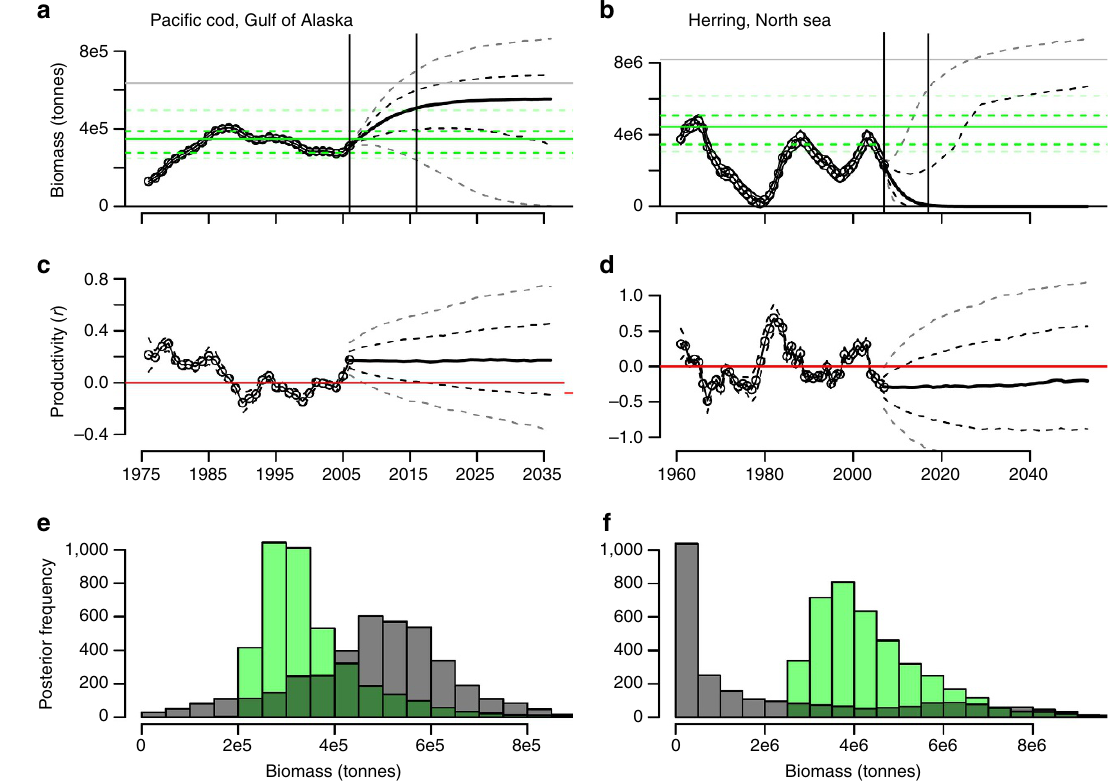
Figure 3 | Examples of recovery timeline forecasting. ( a , b ) Two examples of non-stationary biomass time series to which the non-stationary Graham– Schaefer model was fit. The solid grey lines indicate the mean posterior carrying capacity K ; solid green lines give the mean posterior B MSY (with 50 and 90% intervals as dotted green lines). Vertical black lines differentiate the observed period and 10 years after. The mean biomass trajectories beyond the observed period are given as solid black lines with 50% and 90% intervals as dashed black and grey lines, respectively. ( c , d ) The fitted and forecasted productivity trajectories that drive the biomass predictions (red lines indicate lines of zero net growth). The posterior predictive distribution for recovery after 10 years is then taken from the sample histograms in e , f , where the biomass forecasts are given in grey and the B MSY posterior estimates given in